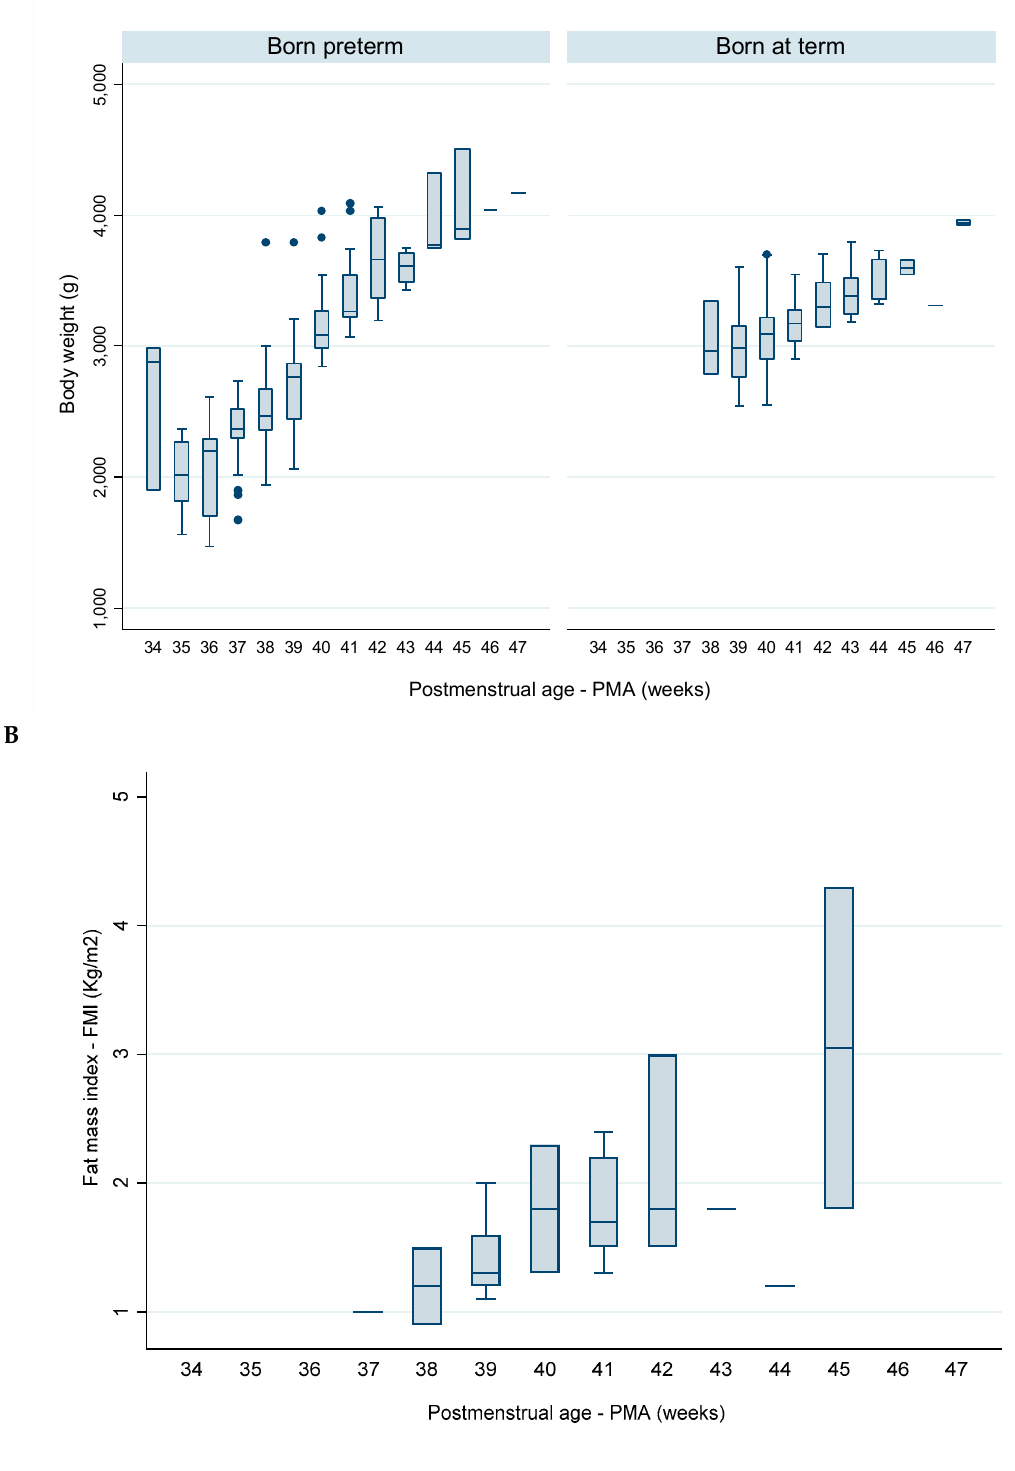
Figure 2. Evolution, per complete week of postmenstrual age, of ( A ) body weight, in infants born preterm (n = 15) and at term (n = 14), and ( B ) fat mass index (FMI), gathering infants born preterm and at term (n = 15). Table 9. Evolution of adiposity indicated by FMI (kg/m 2 ) after term postmenstrual age, in a subset of infants (n = 15) born preterm and at term.